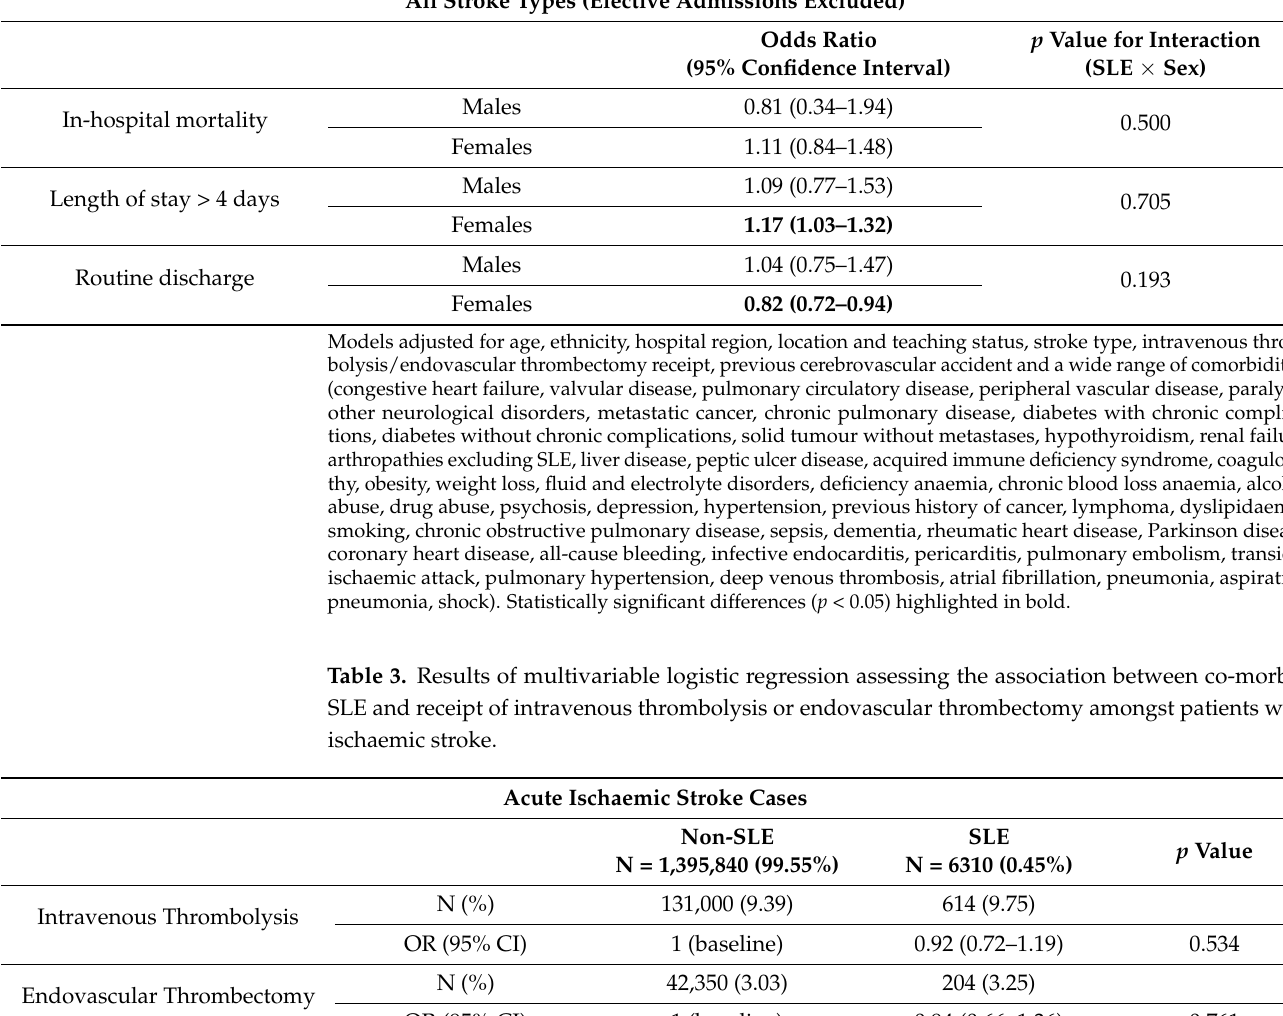
Table 2. Results of multivariable logistic regression assessing the association between co-morbid SLE and all in-hospital outcomes amongst patients with ischaemic and haemorrhagic stroke, stratified by sex, also including the p values assessing the significance of interaction terms between SLE and sex.